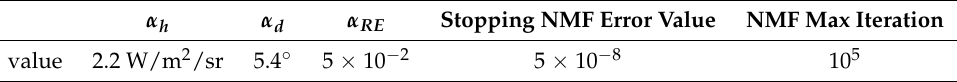
Table 2. HBEE-LCNMF parameter values for the synthetic data